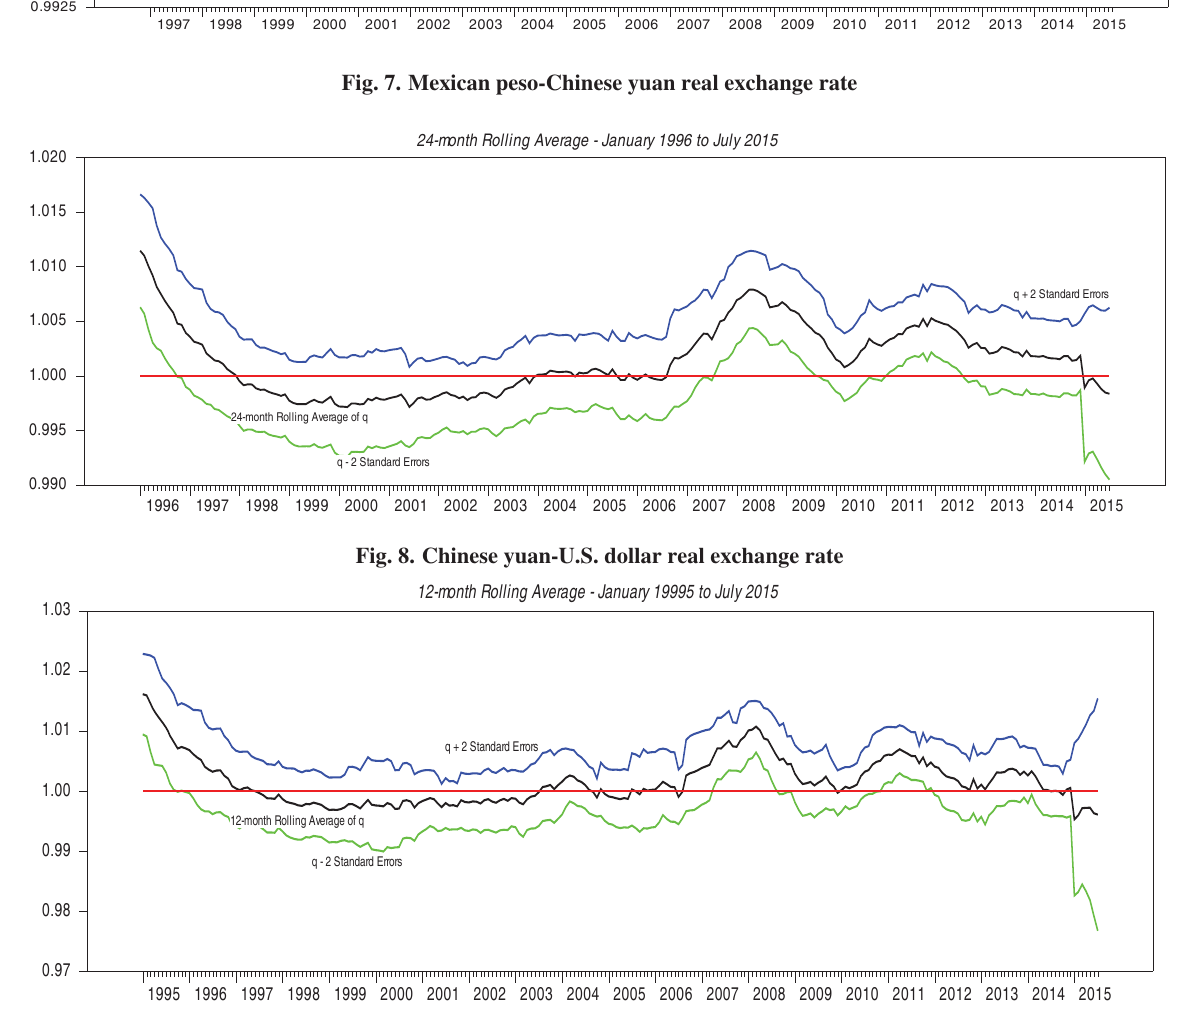
Fig. 9. Chinese yuan-U.S. dollar real exchange